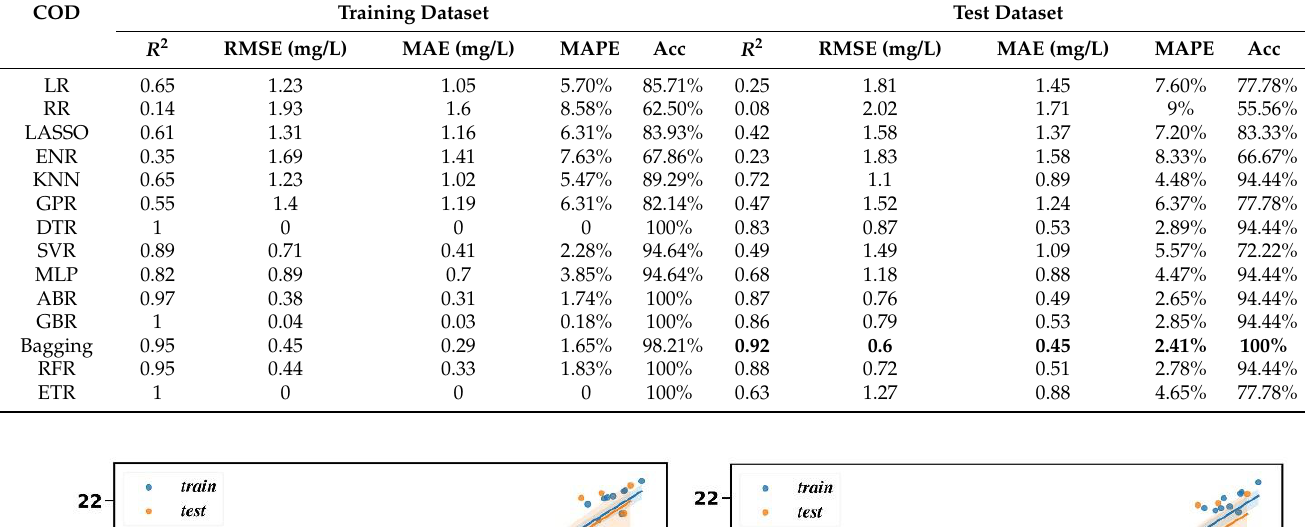
Table 5. Performance of fourteen models on COD training dataset and test dataset.